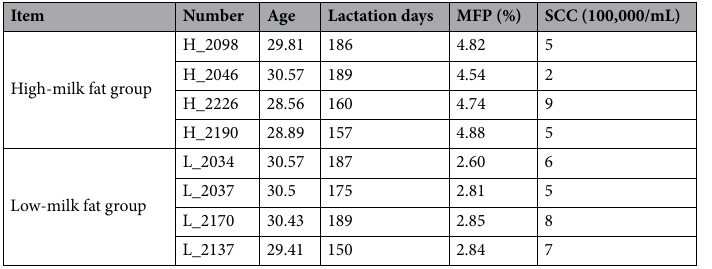
Table 3. High and low MFP of Holstein cattle. Number the number of each cow, MFP milk fat percentage, SCC somatic cell count, age month age of cattle at the time of